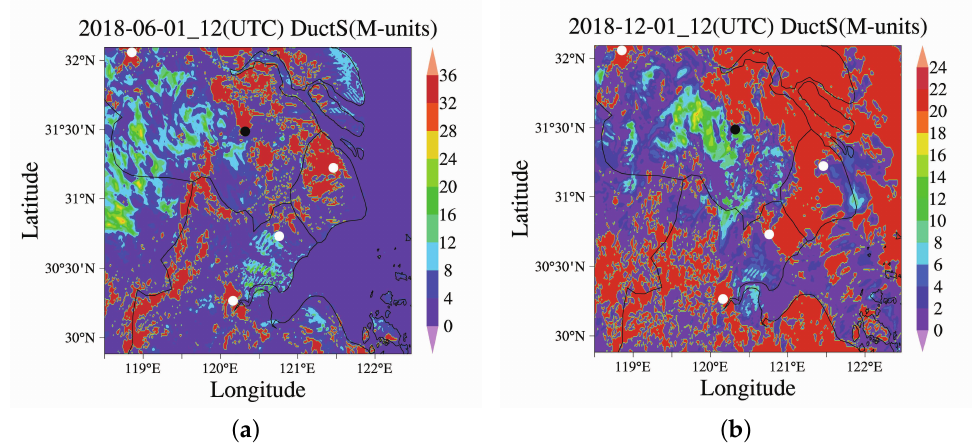
Figure 5. Duct Strength (M-units) calculated by WRF on 1 June and 1 December 2018. ( a ) Duct strength (M-units) on 1 June 2018. ( b ) Duct strength (M-units) on 1 December